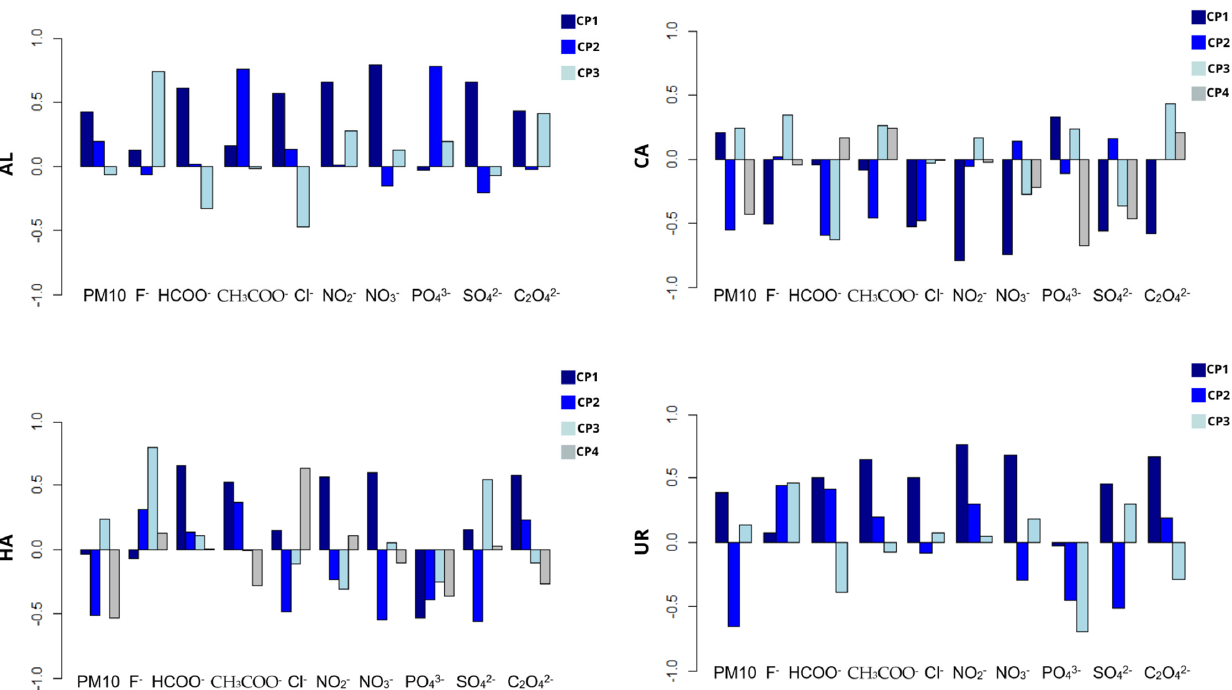
Figure 5. Results of the analysis of the main components of the data for each site.